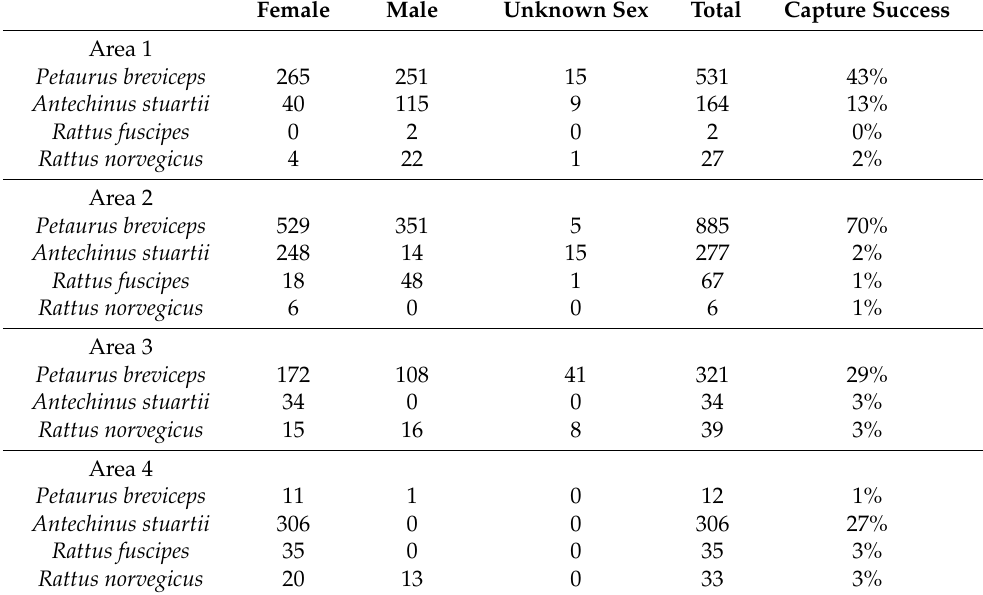
Table 1. Total number of independent observations (separated by 24 h) made for each small mammal. Observations include where individuals were recorded at different sites during a single night. The current study performed 4592 camera trap nights in total, with each area (thus each individual) camera trapped for 28 nights. Capture success was calculated by diving the total number of independent observations made per species, in each area, by camera trap nights. The number of sites in each area was: Area one = 44, Area two = 45, Area three = 40, and Area four = 40. Female Male Unknown Sex Total Capture Success Area 1 Petaurus breviceps 265 251 531